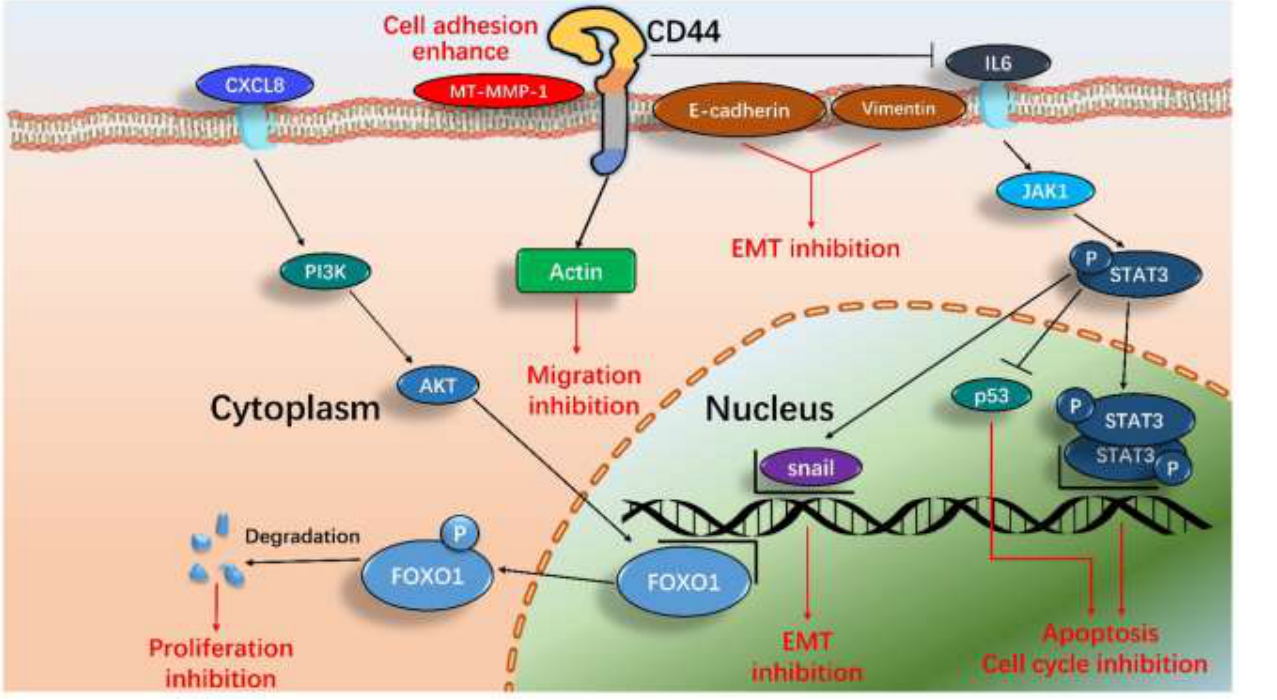
Figure 11. The proposed pathways of major signals induced by DS − 1 in U − 2 OS cells include inhibiting the EMT pathway, enhancing cell adhesion by CD44 actin protrusions, inhibiting the cell cycle, and inducing cell apoptosis by means of the IL-6-STAT3 signaling pathway and CXCL8-PI3K/AKT-FOXO1 signaling pathway.